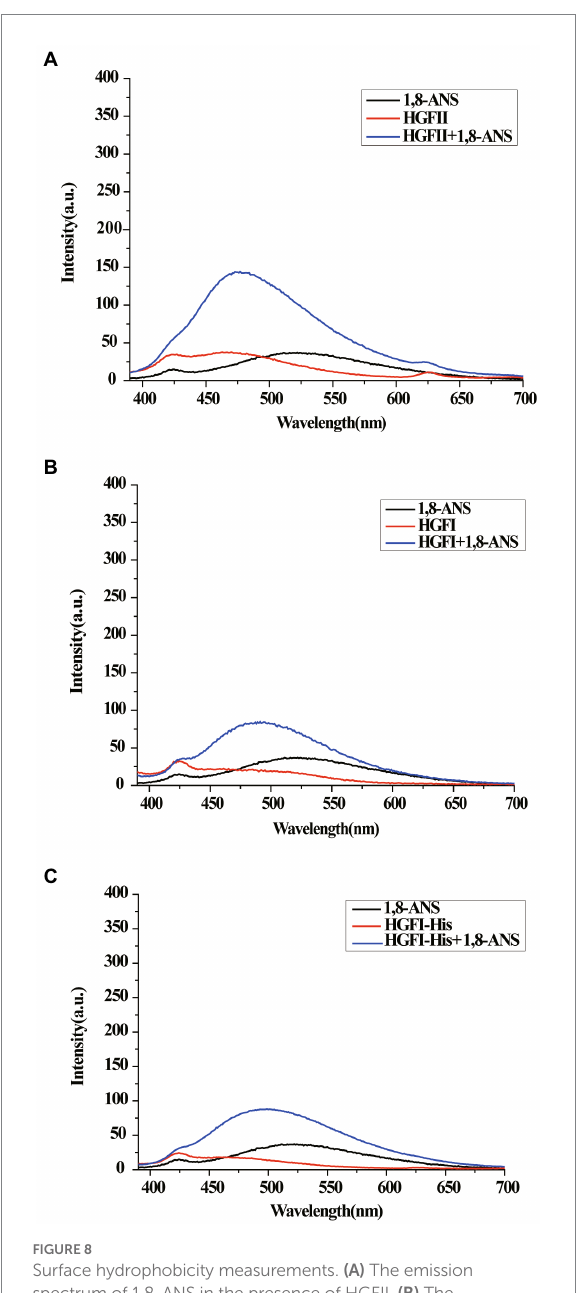
FIGURE 8 Surface hydrophobicity measurements. (A) The emission spectrum of 1,8-ANS in the presence of HGFII. (B) The emission spectrum of 1,8-ANS in the presence of HGFI. (C) The emission spectrum of 1,8-ANS in the presence of HGFI-His.